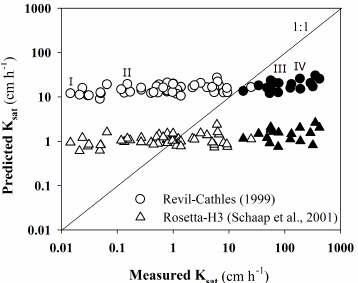
Figure 4. Predictive performance of empirical saturated hydraulic conductivity ( K sat ) models. Filled symbols represent samples with biopore-dominated flow and empty symbols represent samples with matrix-dominated flow. Visualizations of samples marked as I, II, III, and IV are depicted in Fig.